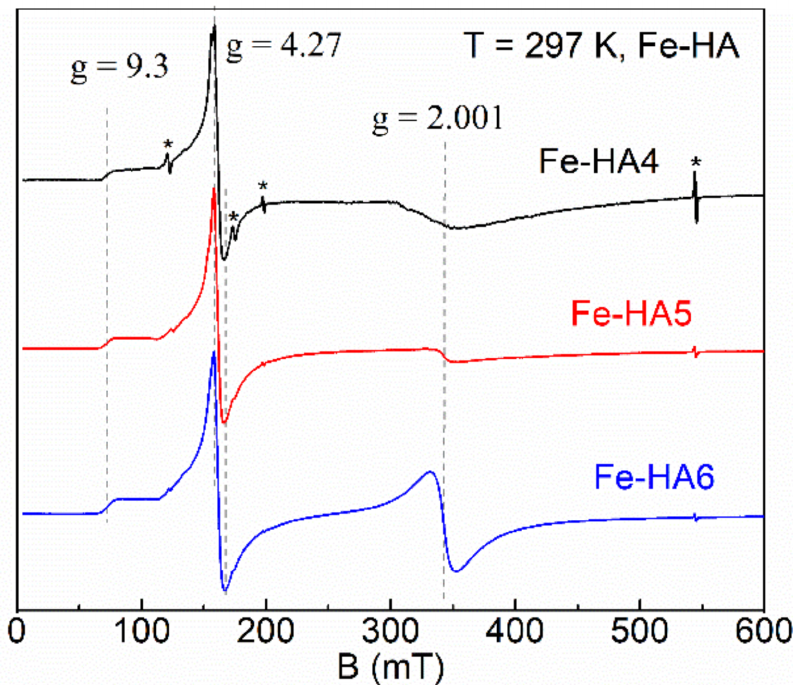
Figure 7. Normalized electron paramagnetic resonance (EPR) spectra for Fe-HA4 (upper curve), Fe-HA5 (middle curve), and Fe-HA6 (lower curve) samples. Dashed lines indicate the absorption features of Fe 3+ ions; asterisks indicate the internal EPR cavity signals used as